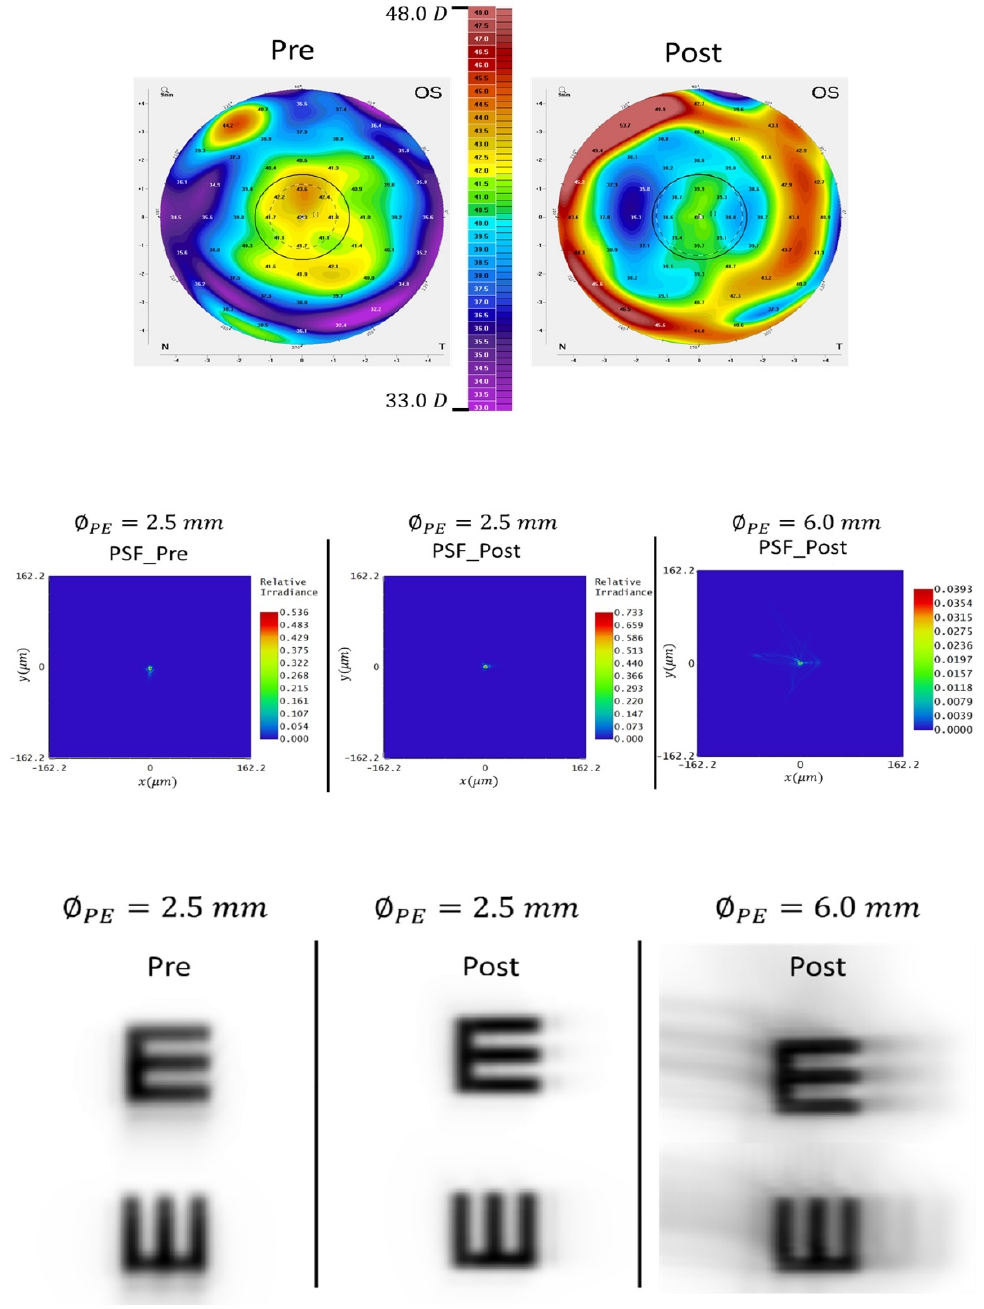
Figure 5. For Eye 2, ( up ) pre and postoperative topographies. Pupil size of 2.5 mm centred in apex is indicated with black circle; ( middle ) pre and postoperative PSF functions for 2.5 mm and 6 mm pupil sizes; ( down ) pre- and postoperative vision simulated optotype for 2.5 mm and 6 mm pupil sizes.